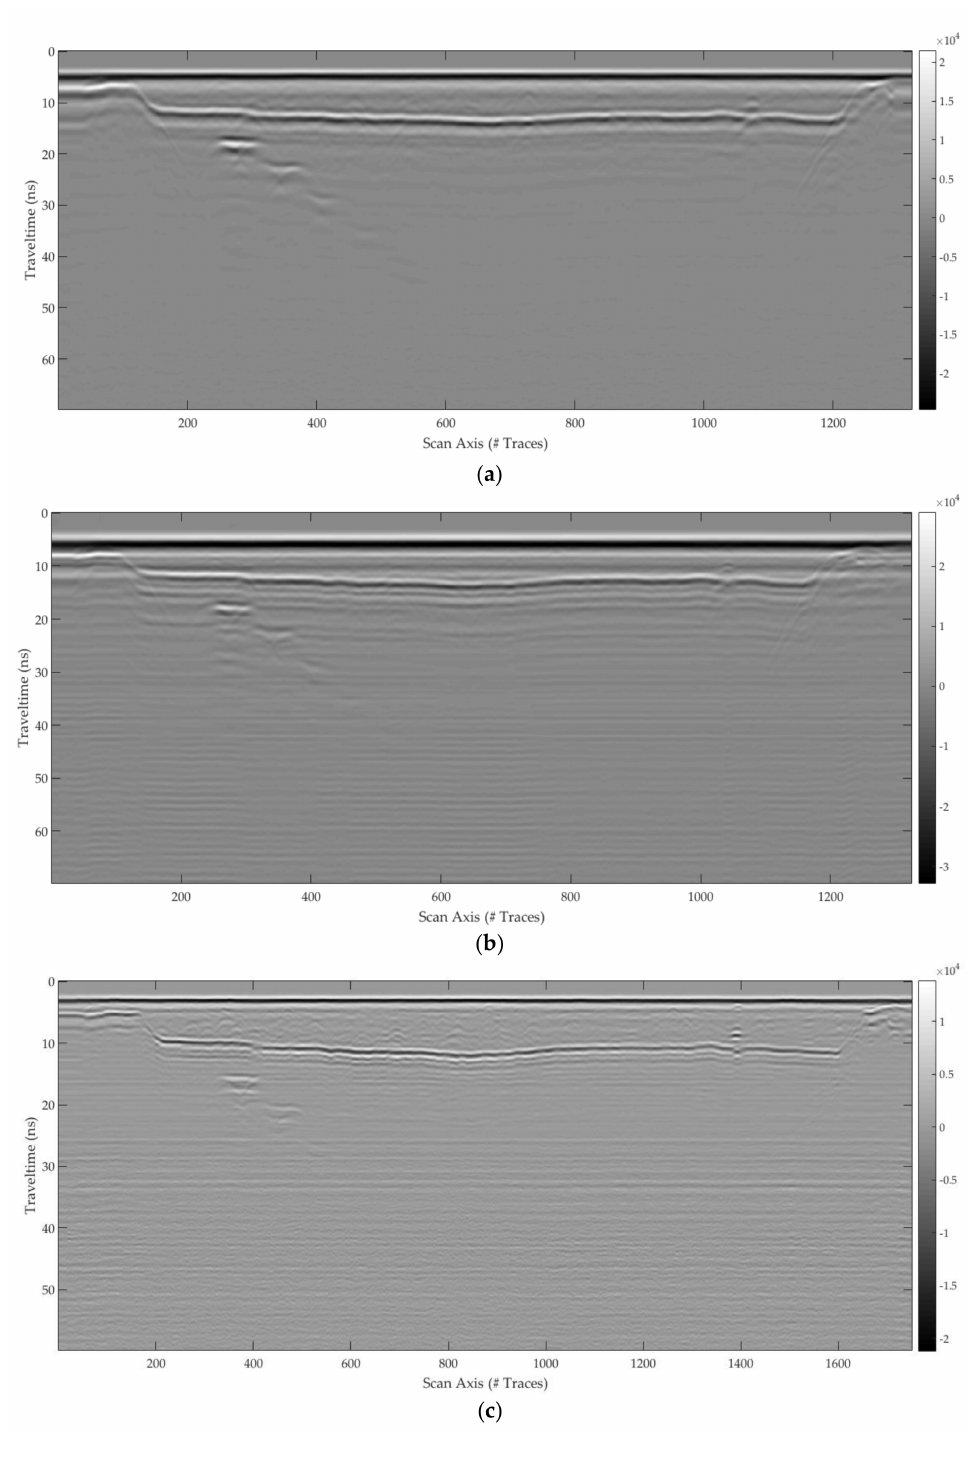
Figure 16. Profiles recorded in the silt region by using GPR 1, on acquisition line 1, with antennas operating at the following central frequencies: ( a ) 400 MHz; ( b ) 500 MHz; ( c ) 900 MHz. Data recorded at 200 MHz are shown in Figure